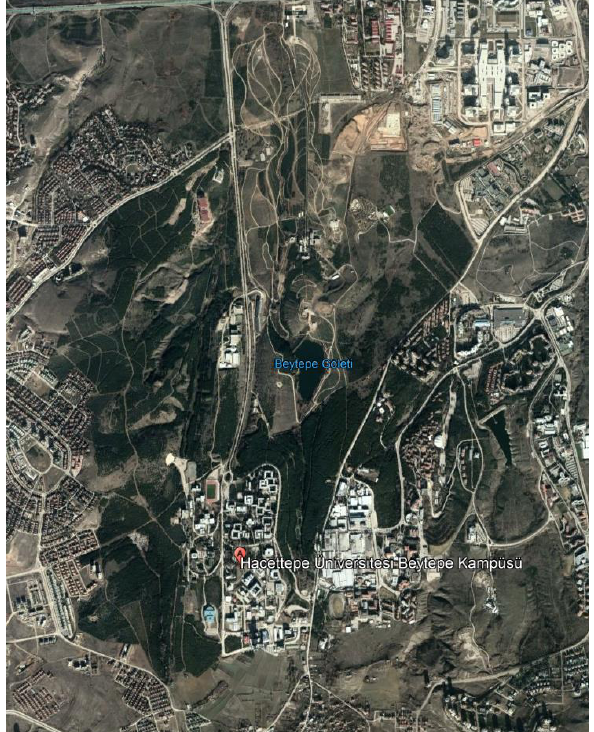
Figure 1. An overview of Hacettepe University, Beytepe Campus, Ankara (image credit: Google Earth).